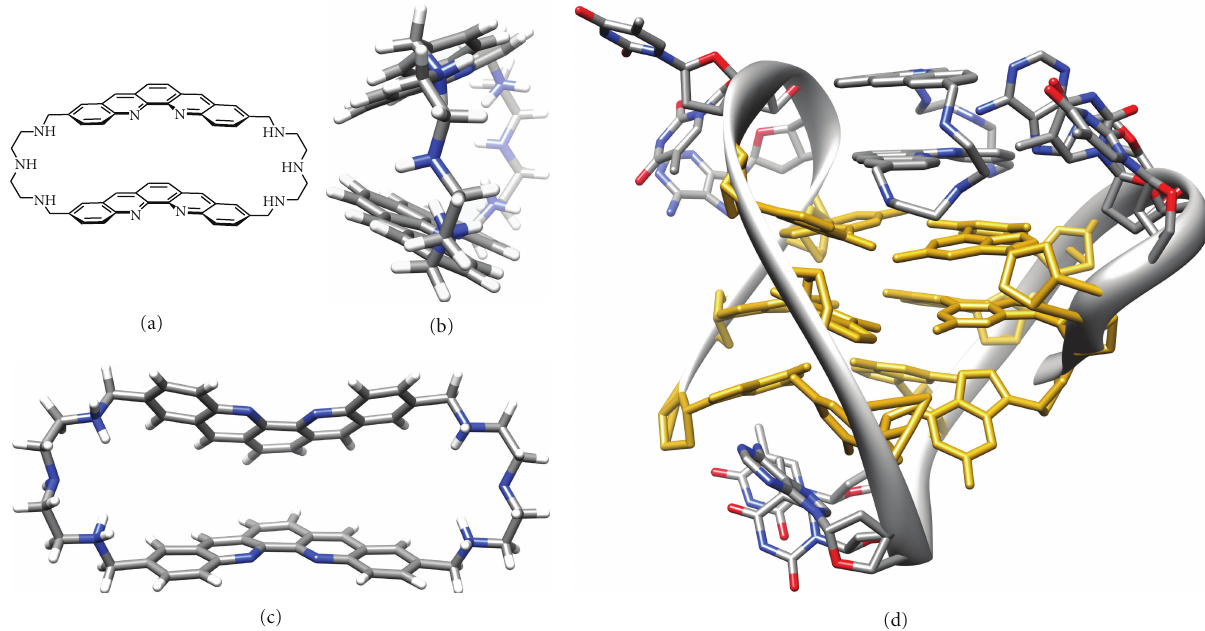
Figure 14: Structure of BOQ 1 (a), side (b), and front views (c) of the lowest-energy conformation during the molecular dynamic simulation (see [39]) and modelled interaction between BOQ 1 and the human telomeric quadruplex ((d), see [205]); guanine residues appear in gold; the carbon, nitrogen, oxygen, and hydrogen atoms appear in grey, blue, red, and white, respectively.